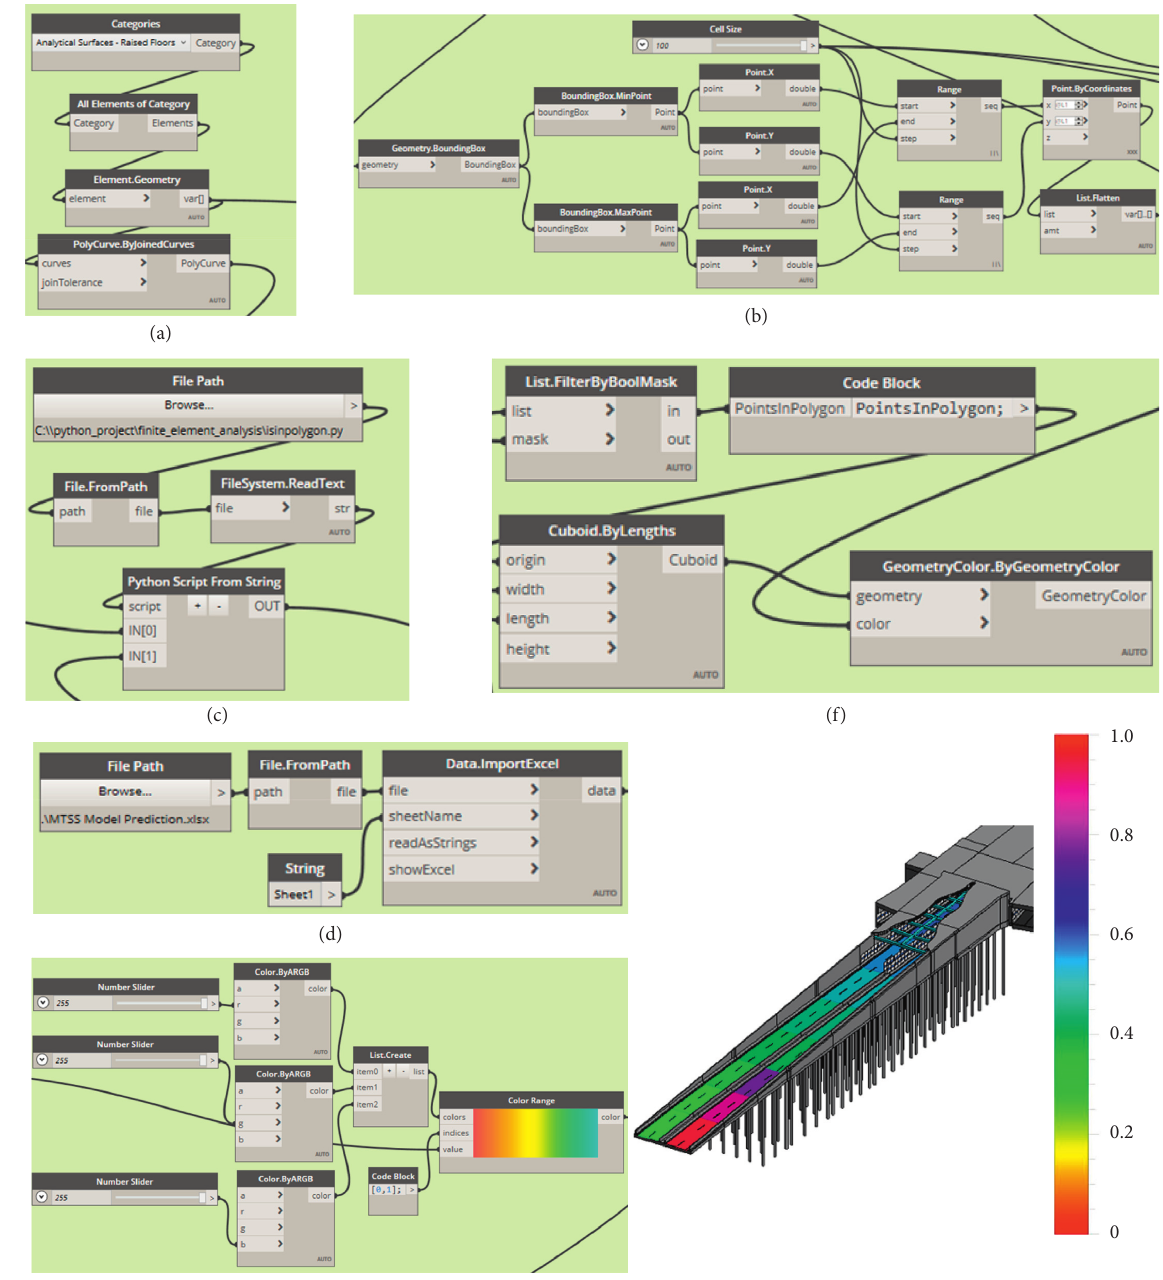
Figure 18: Visual presentation of pavement performance prediction in Dynamo. (a) Import the Revit highway BIM model. (b) Create highway segment element. (c) Import Python script. (d) Import MTSS highway segment performance prediction results. (e) Create a chromatogram. (f) Visualize the changing trend of highway segments.